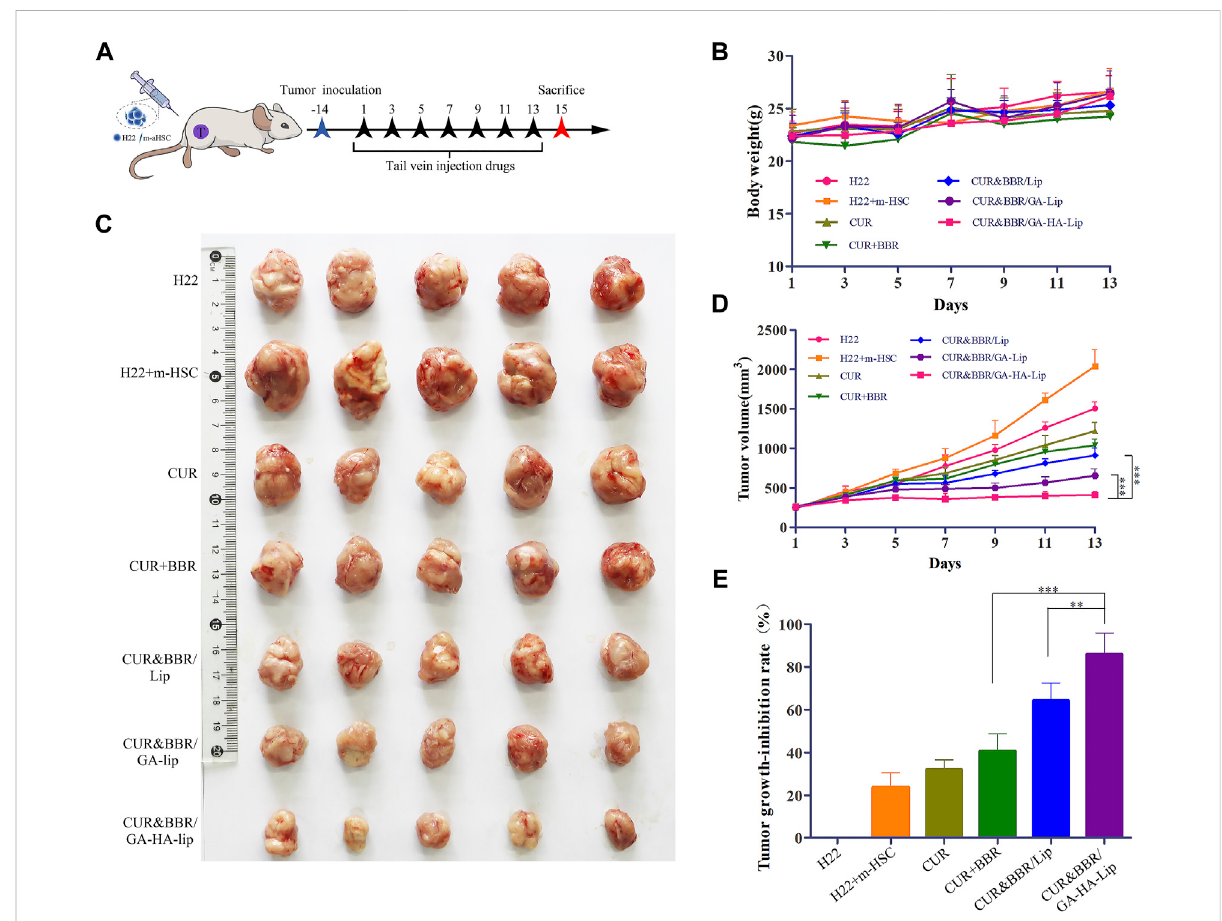
The anti-tumor evaluation of the H22+m-HSC tumor-bearing mice model. (A) Scheme of the strategy for the H22+m-HSC tumor-bearing mice model. (B) Body weight. (C) Images of tumor tissue in different treatment groups. (D) The curve of tumor volume during treatment. (E) Analysis of the tumor inhibition rate of different